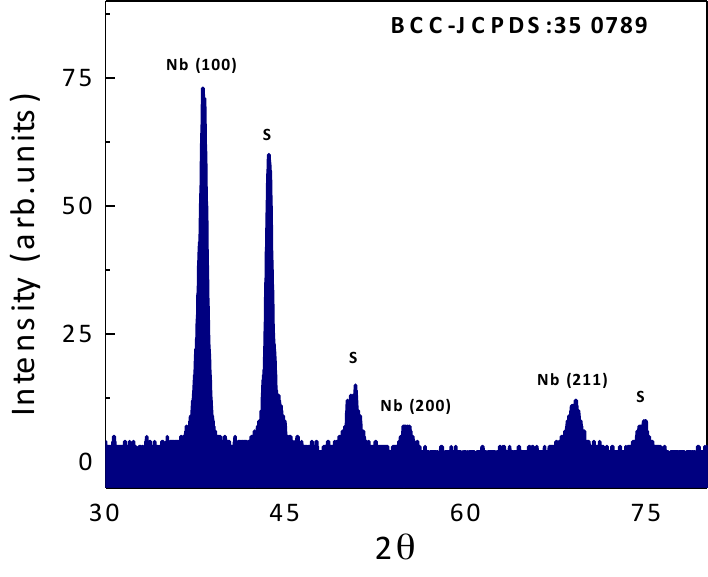
Figure 1. X-ray diffraction pattern of the Nb thin films. The intensity of the substrate peaks (s) is high due to the small thickness of the